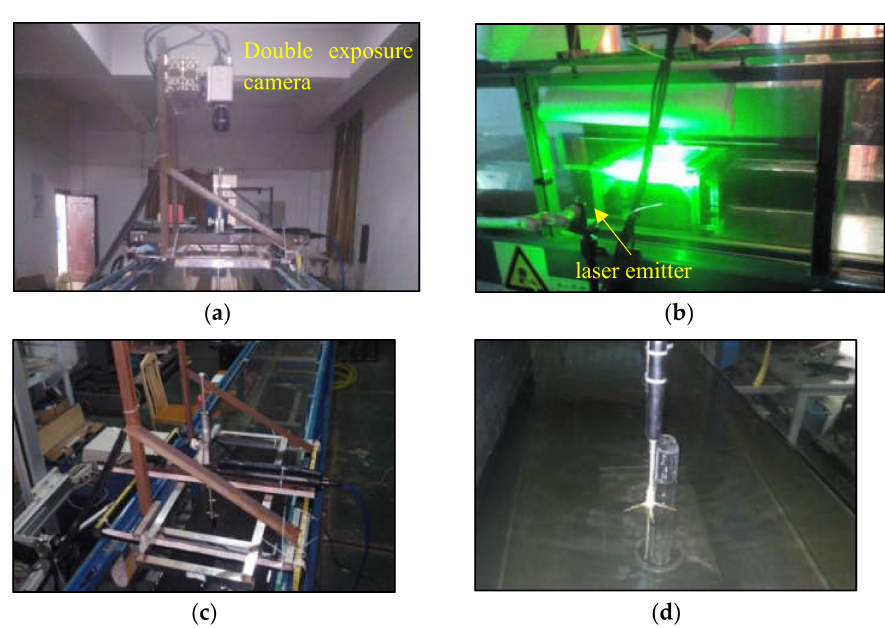
Figure 3. Schematic of the test instrument layout: ( a ) Double exposure camera layout; ( b ) Schematic of laser emitter placement; ( c ) ADV test frame; ( d ) ADV measuring